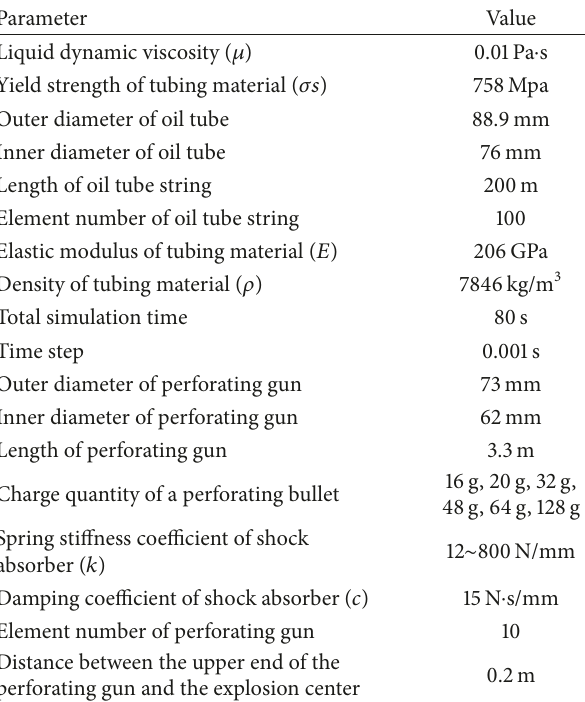
Table 3: Basic perforation